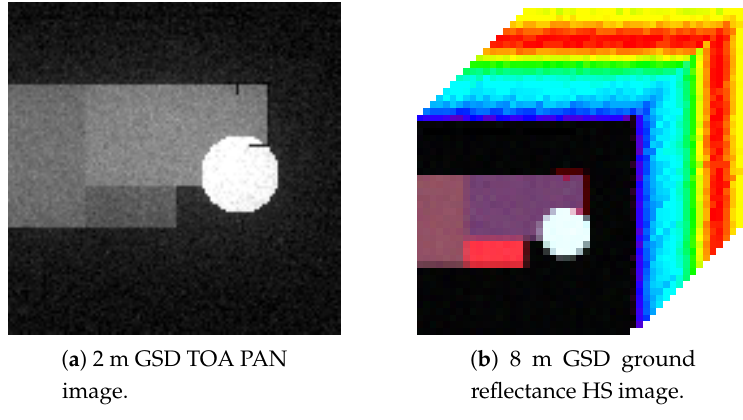
Figure 5. Synthetic data